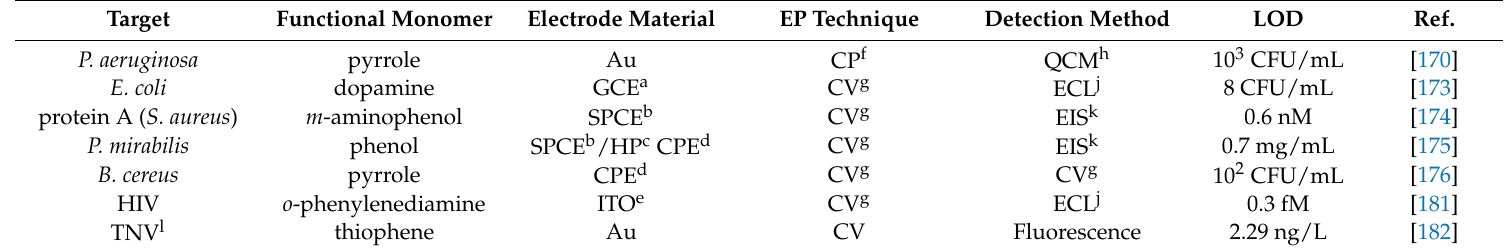
Table 5. Summary of recent publications for the detection of bacteria and viruses using eMIPs. Includes information on the functional monomer used, electrode material, polymerization technique, detection method, and